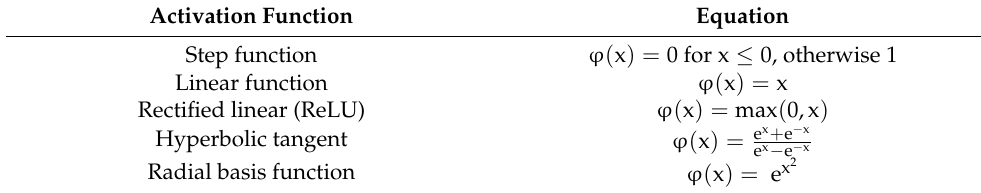
Figure 3 . Network Functioning. X i is the input parameter; wi is the weight; Σ is the transformation function, which can be the identity, b is the bias; and φ is the activation function. Table 1. Activation functions of the ANNs.